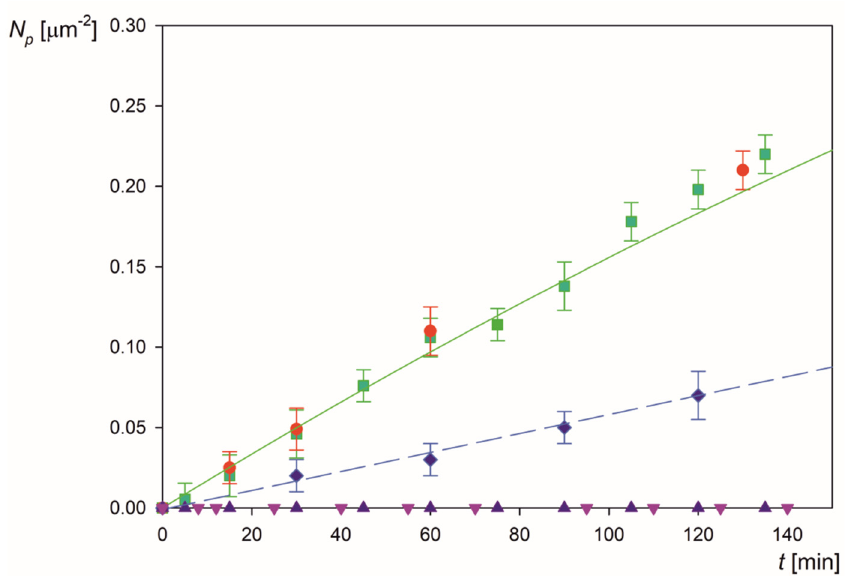
Figure 6. The kinetics of LSFi particle deposition at mica in the OBIJ flow cell, shown as the dependence of the surface concentration on the deposition time, particle concentration 100 mg L − 1 , 0.001 mol L − 1 NaCl; flow rate 2.5 × 10 − 3 cm 3 s − 1 . The points show the results obtained for various pHs: pH 3.5 ( ● ); pH 4 ( ■ ), pH 4.5 ( ♦ ); pH 5.5 ( ▲ ); pH 7.4 ( ▼ ); The solid line shows the theoretical results derived from the convective diffusion model with the RSA blocking function.